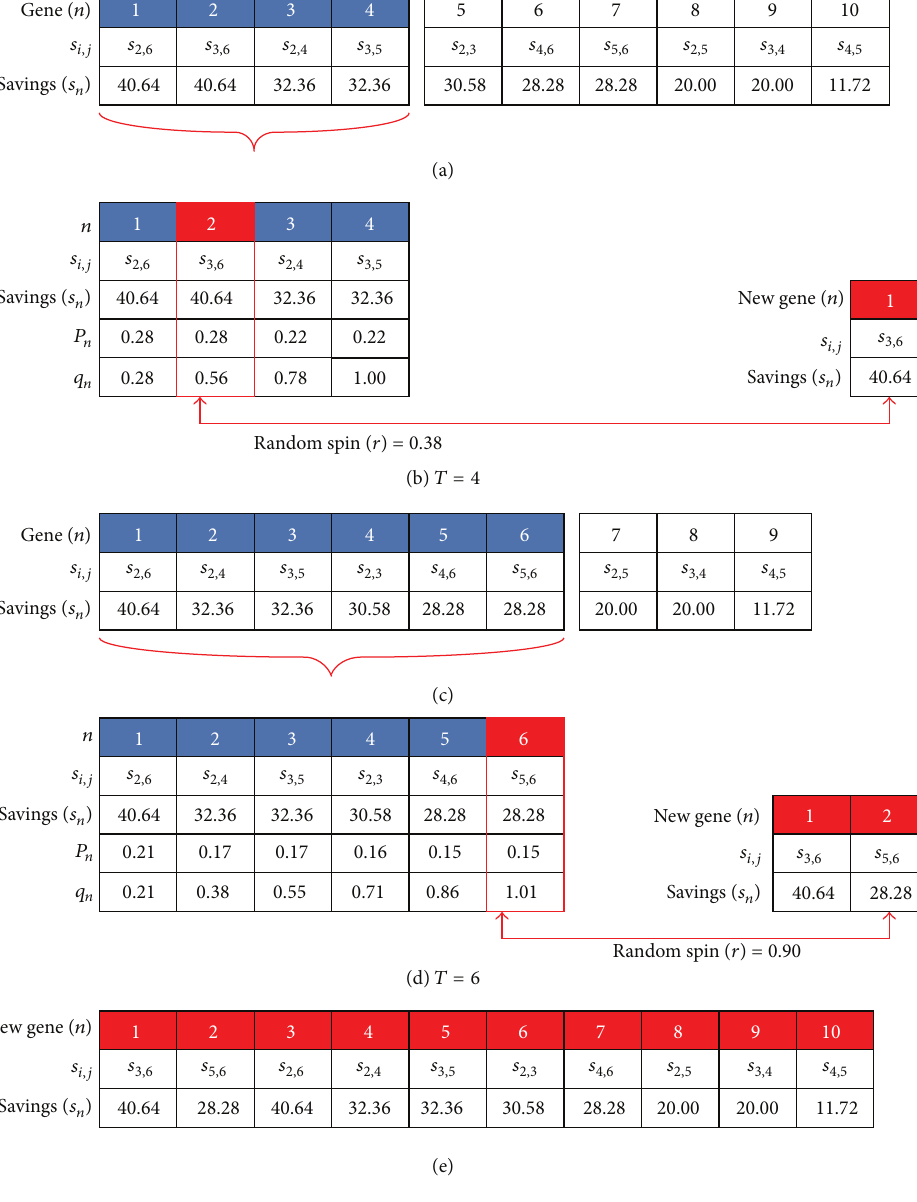
Figure 5: The example of the two-phase selection